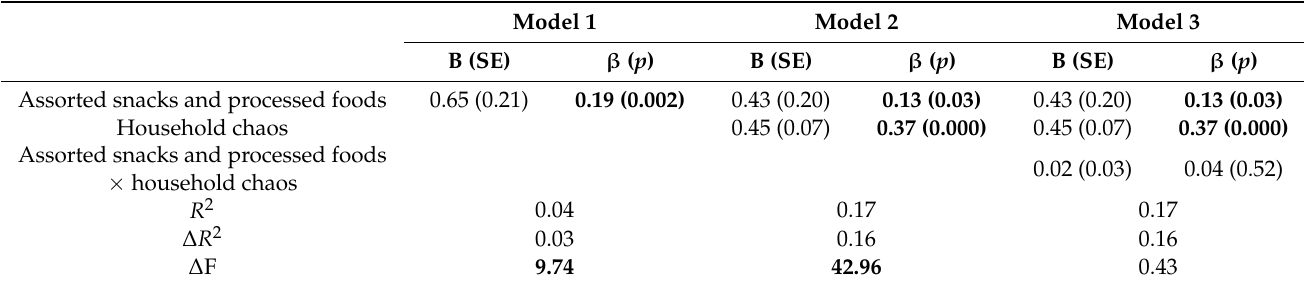
Table 5. Multiple Regression Analyzing Associations Between Assorted Snacks and Processed Foods, Household Chaos, and Emergent Metacognition Index (EMI).